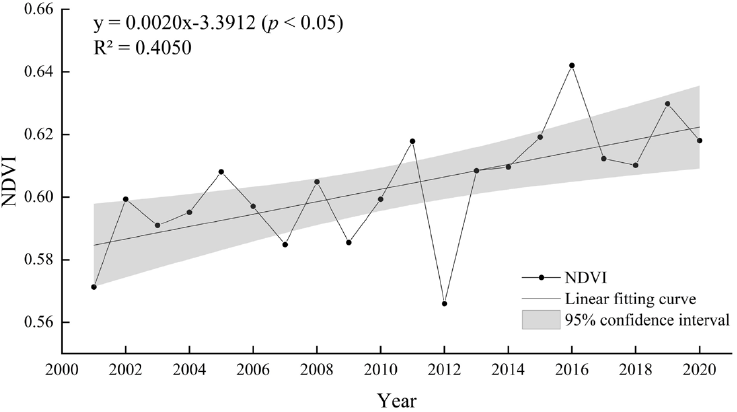
Figure 2. Interannual variation of NDVI in the growing season of the Minjiang River Basin from 2001 to 2020.